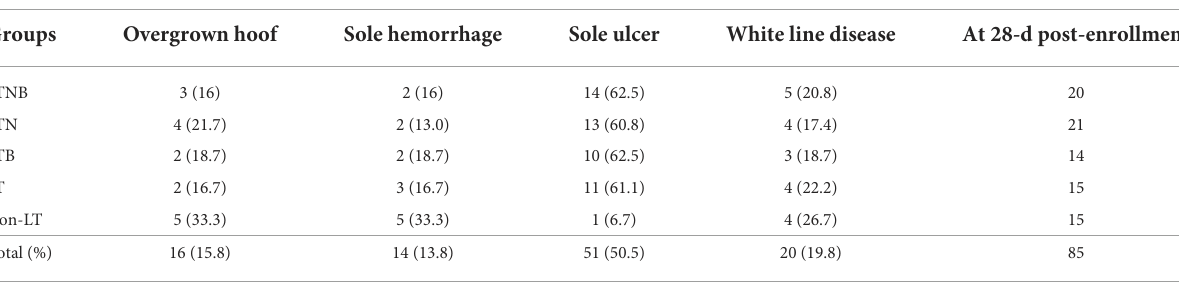
TABLE 3 Number of cows allocated to each treatment based on claw lesion diagnosis and overall cows that completed the trial. Claw lesion diagnosis